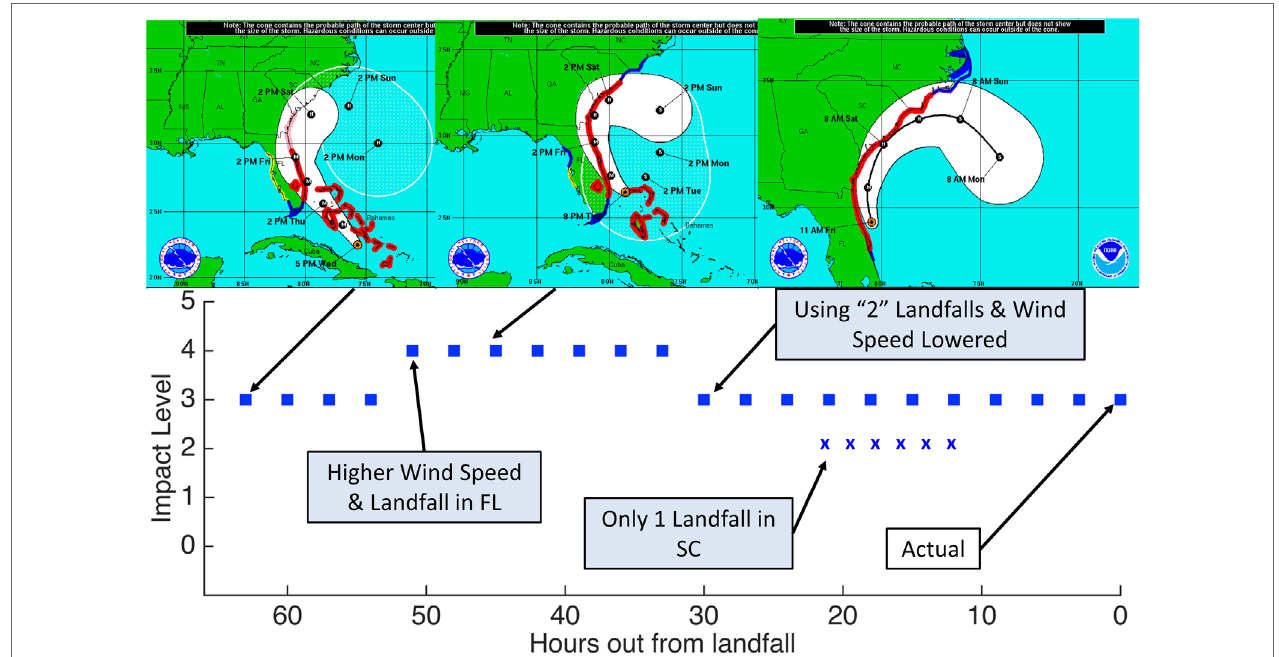
FigUre 9 | 2016 Hurricane Impact Level (HIL) Model forecasting results, with comparison to actual impact level (IL), for Hurricane Matthew. Model confidence in forecast IL shown in